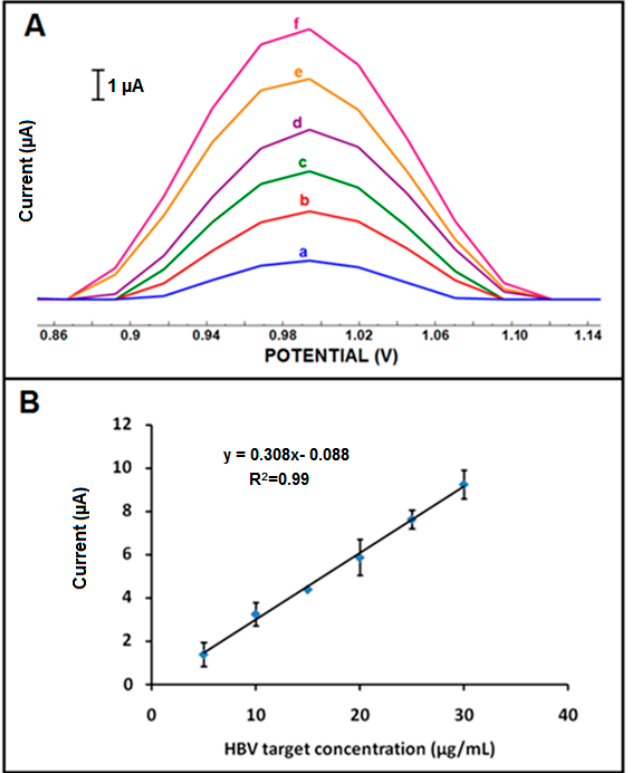
Figure 7. ( A ) DPVs represent the average guanine oxidation signals (n = 3) after hybridization be- tween amino linked HBV probe and (a) 5, (b) 10, (c) 15, (d) 20, (e) 25, and (f) 30 µg/mL HBV targets in FBS medium onto the surface of CoPc-IL-PGE. ( B ) Calibration plot obtained from guanine oxida- tion signals after hybridization of HBV probe with different concentrations of HBV target in FBS medium onto the surface of